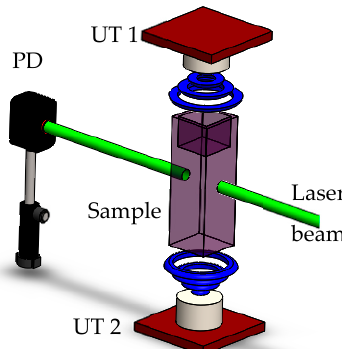
Figure 3. Single-beam transmittance set-up based in an Nd:YVO 4 pulsed laser.